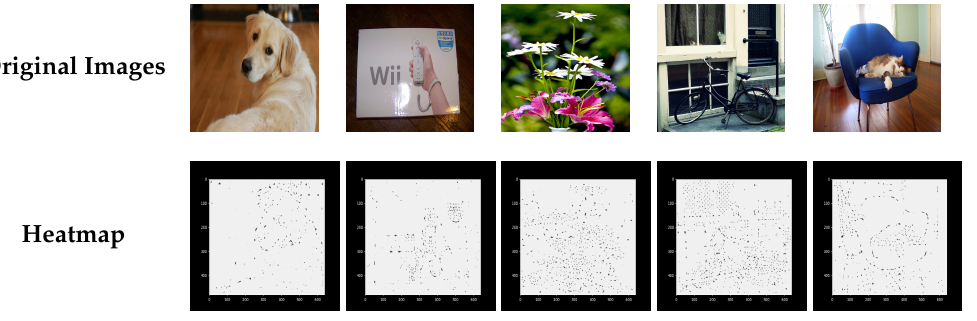
Figure 11. SuperPoint’s detector output probability